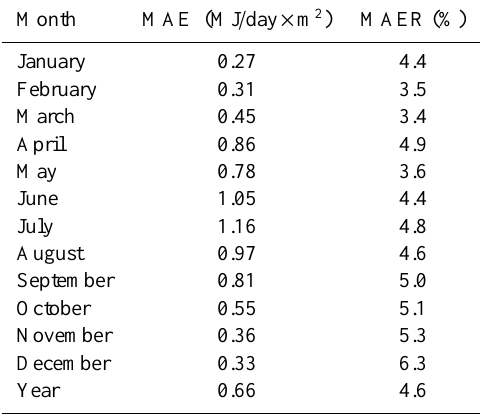
Table 2. Estimated global radiation MAE (MJ / day × m 2 ) and MAER (%) evaluated comparing the modeled climatologies with the station 1961–1990